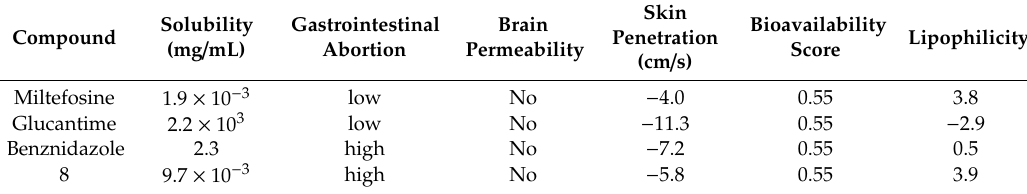
Table 5. Pharmacokinetic parameters predicted using